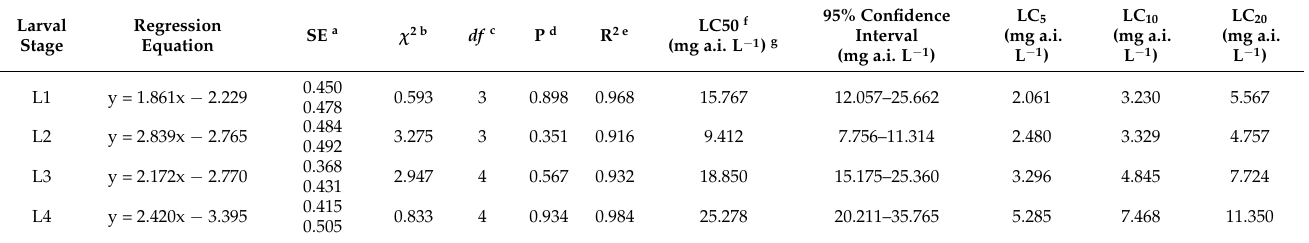
Table 1. The 48 h LC 50 of acetamiprid for C. septempunctata within different larval stages. Larval